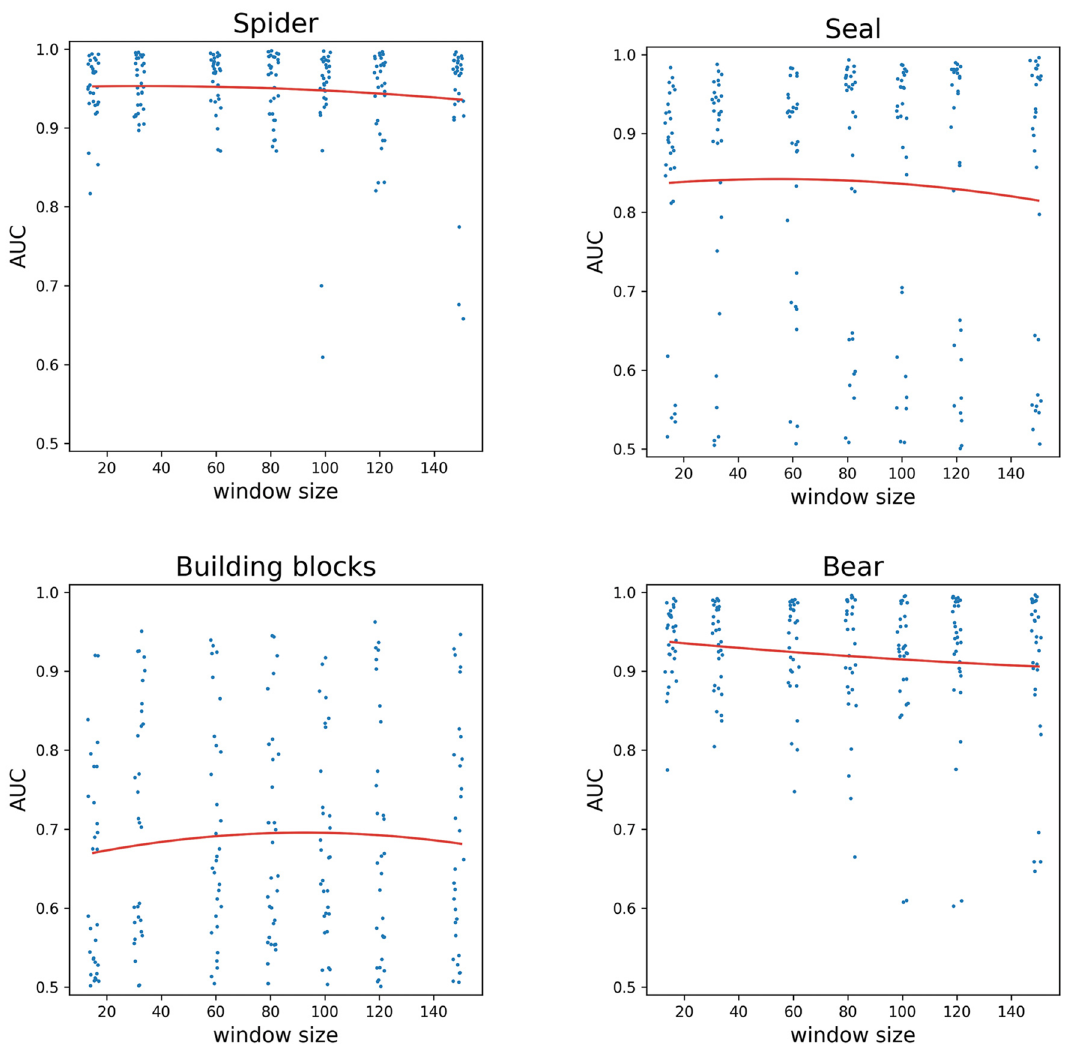
Figure 3. Playful activities with the highest AUC values, AUC values as a function of the window size. Quadratic curves fitted (Spider: adj. R 2 = 0.091, Seal: adj. R 2 = 0.327, Building blocks: adj. R 2 = 0.036, Bear: adj. R 2 = 0.115). A small random jitter was added to the window sizes for better